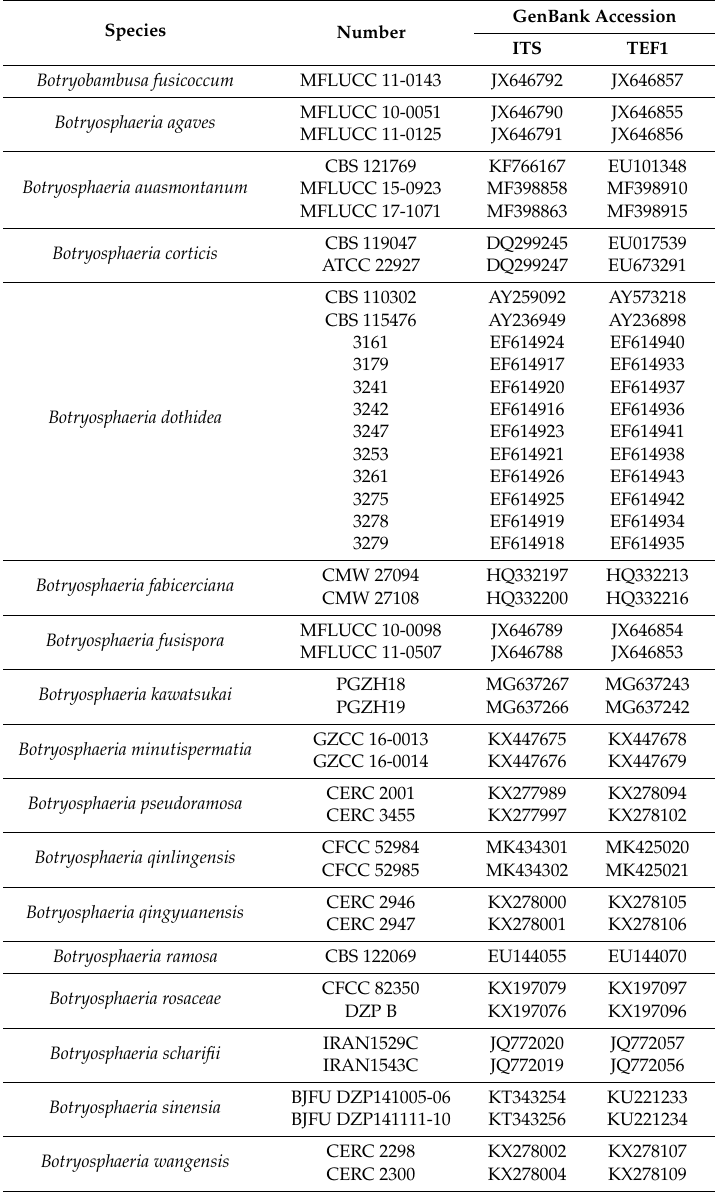
Table 3. Reference strains used in the phylogenetic